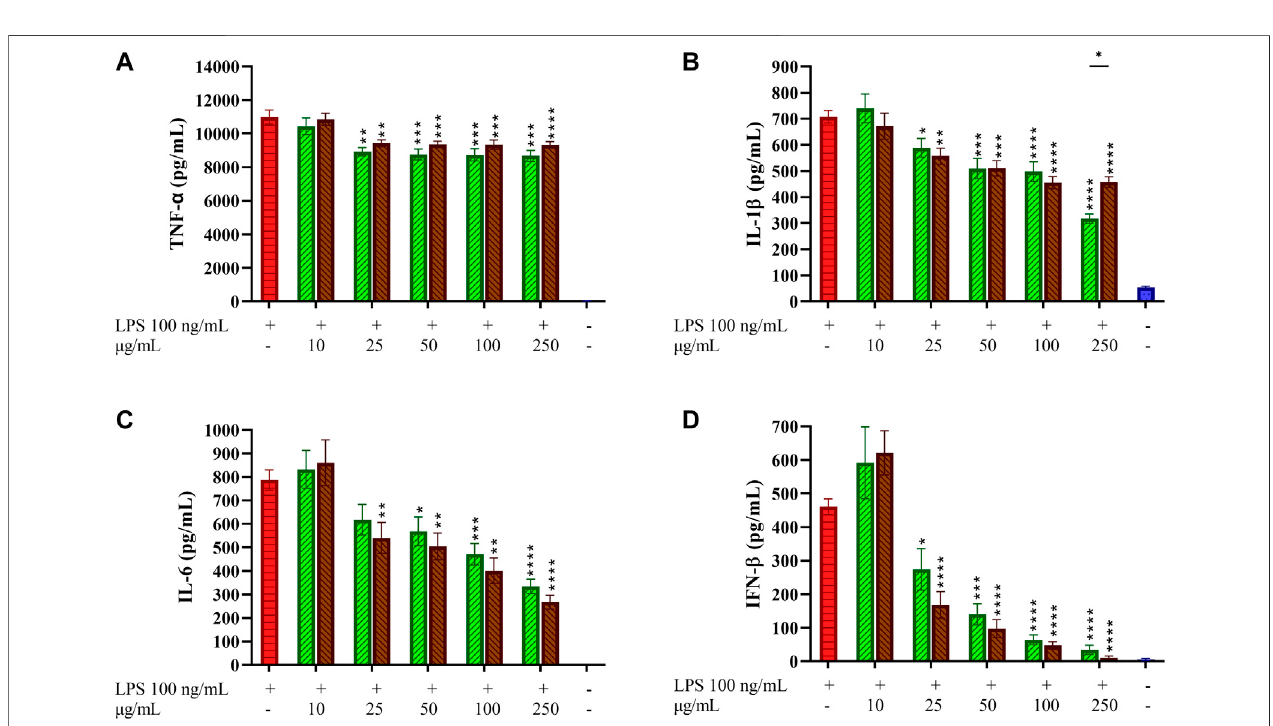
FIGURE 3 | Pro-in fl ammatory cytokines pro fi ling in LPS-stimulated THP-1-derived macrophages. THP-1-derived macrophages (TDM) cells were pre-treated with increasingconcentrationsofGCE(green,down-updiagonalpattern)andRCE(brown,up-downdiagonalpattern)for1 handthenchallengedwith100 ng/mlLPS.TNF- α (A) , IL-1 β (B) , IL-6 (C) and IFN- β (D) released in the medium after 24 h were quanti fi ed via ELISA. Data are represented as mean ± SEM of three independent experiments ( n = 3). (one-way ANOVA, * p < 0.05, ** p < 0.01, *** p < 0.001, **** p <